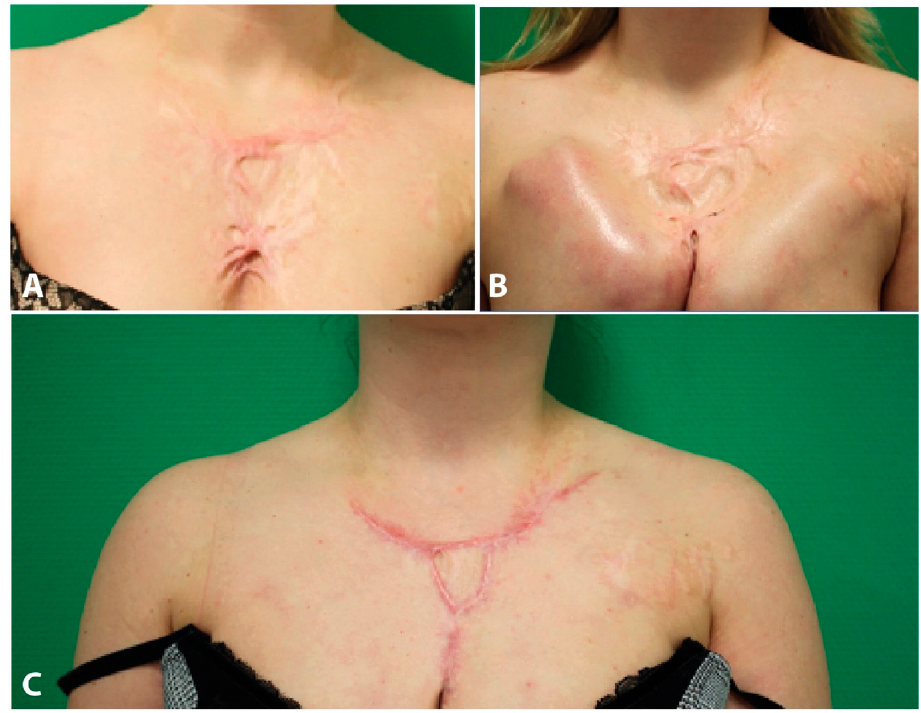
Figure 6. ( A ) Hypertrophic scar in the chest area, ( B ) After expander implantation, ( C ) Outcome after 6 month.